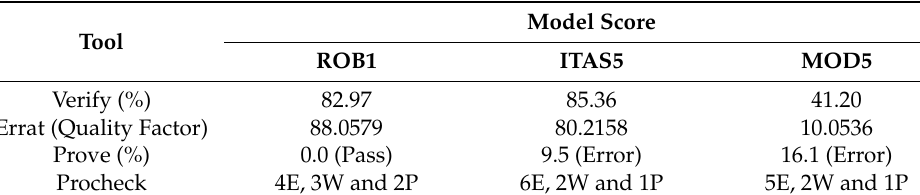
Table 5. Model evaluation of the top 3 Ld CRK12 structures modelled via Modeller, Robetta, and I-TASSER. Models ROB1, ITAS5, and MOD5 were generated using Robetta, I-TASSER, and Modeller, respectively. E: error; W: warning; and P: pass.